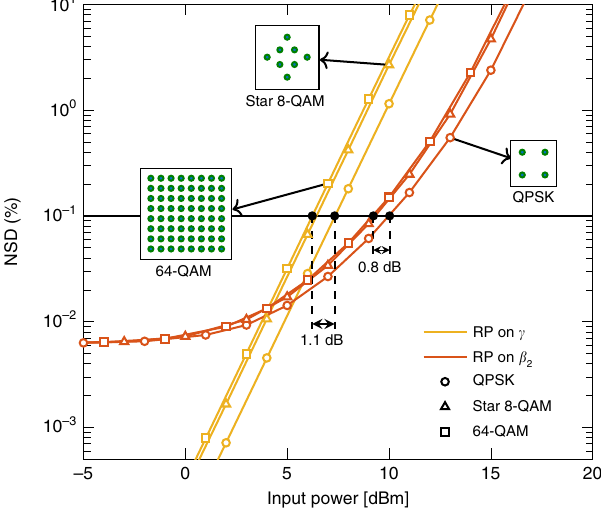
Fig. 8 Impact of QPSK, star 8-QAM, and 64-QAM modulation formats on the NSD versus input power. The system consists of an 80 km NZDSF with 10 Gbaud symbol rate. The modulation format impact is measured by the power gap in dB between the crossing points of the NSD curves for each modulation format with the horizontal black curve representing a constant 0.1% NSD.